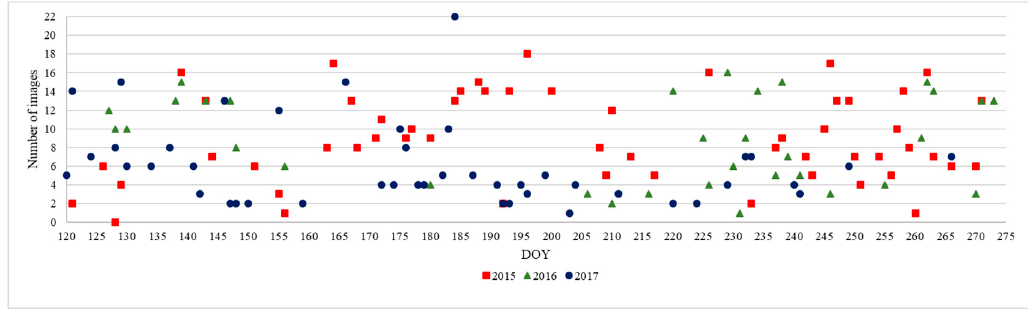
Figure 2. Heilongjiang Province 2015–2017, three-year time series distribution map, including the number of scene images available for each day of the year (DOY).